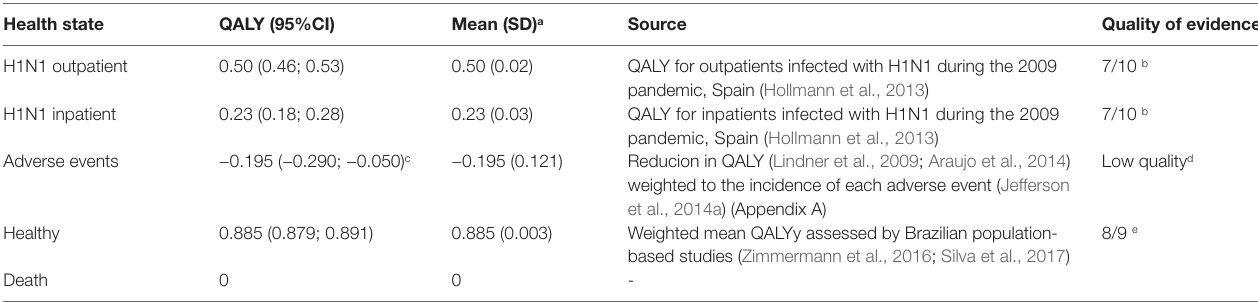
TABLE 2 | Utilities considered in the